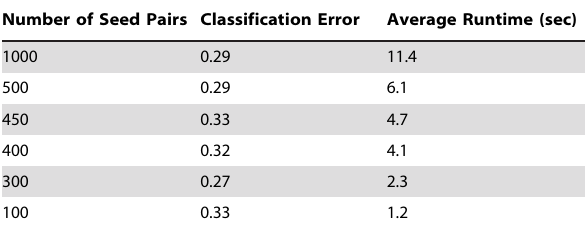
Table 9. CE and average runtime per alignment for various seed pair restrictions. Number of Seed Pairs Classification Error